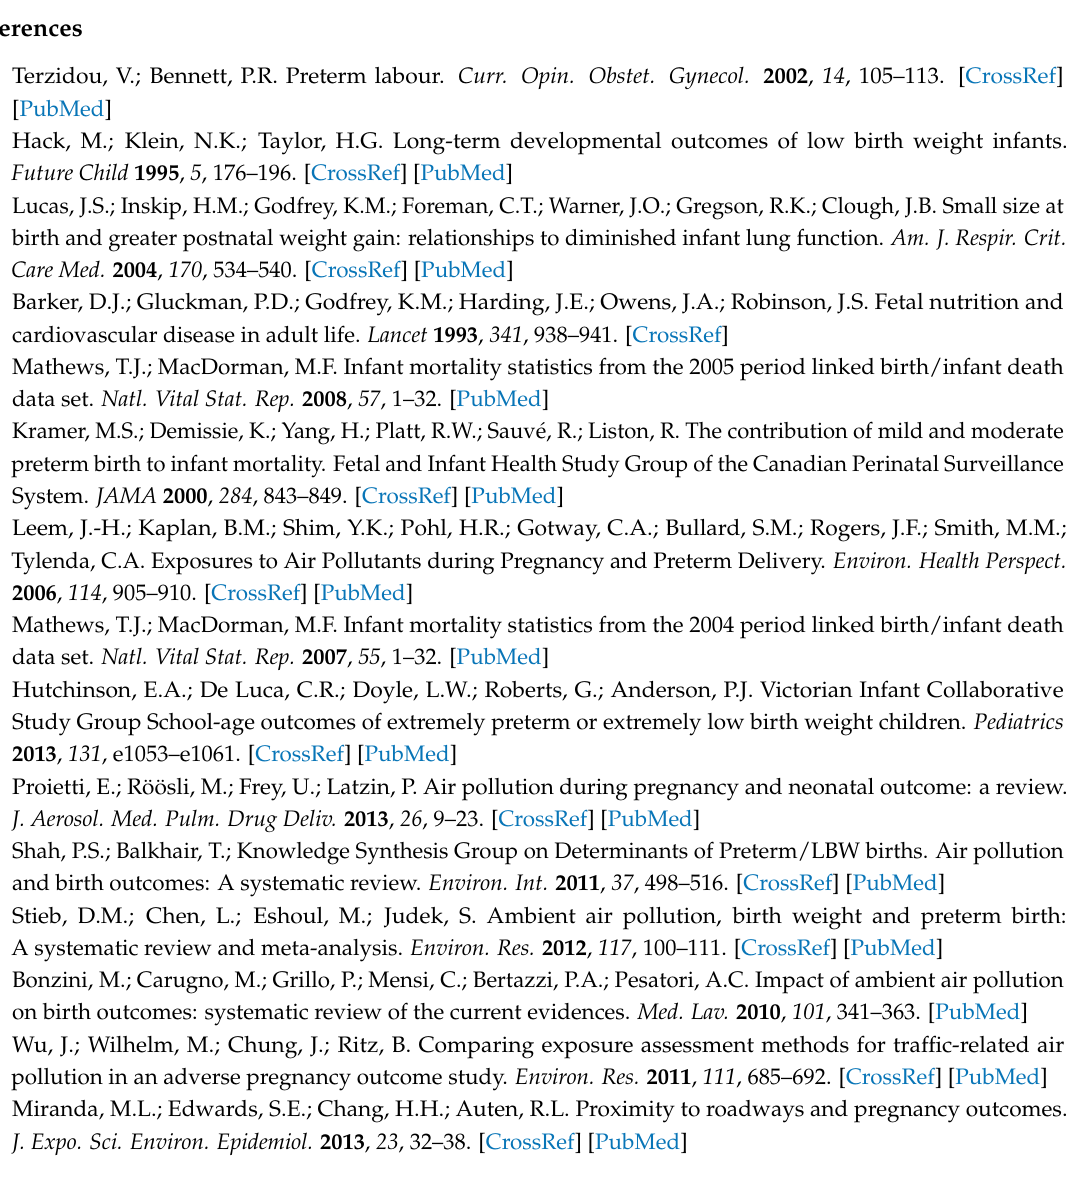
Figure S1: Scatterplot matrix of NO 2 , PM 10 and PM 2.5 , Table S1: Correlation Matrix between NO 2 , PM 10 and PM 2.5